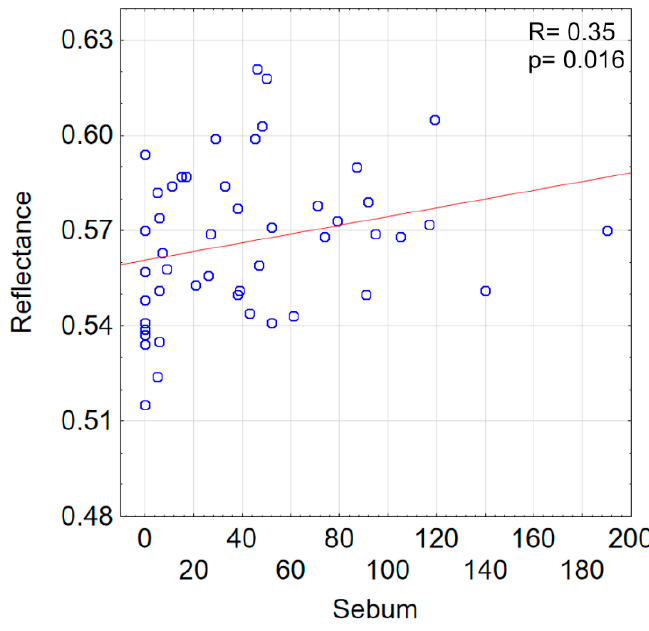
Figure 6. Correlation of sebum and skin reflectance at the wavelength 590–720 nm. Red line—trend line.